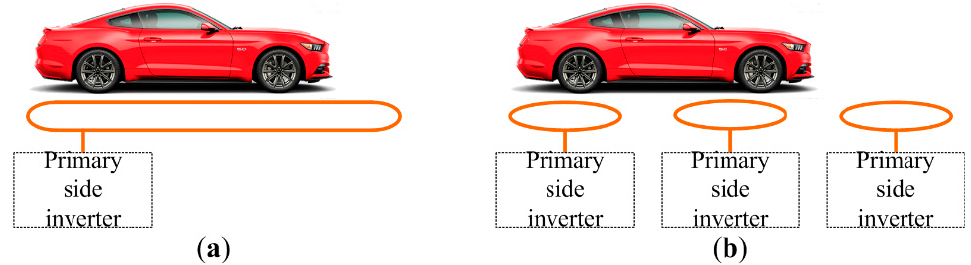
Figure 1. Classical structures of a DWPT: ( a ) centralized and ( b ) segmented. Table 1 clarifies the limitations of uneven energy transfer and compares its magnitude in different situations, mainly in the segmented structure of a DWPT. The decrease in the transmission power can be more than 50% of the maximum value (up to the absence of the received energy at certain intervals). Table 1. Comparison of non-uniformity of energy transmission for a DWPT.